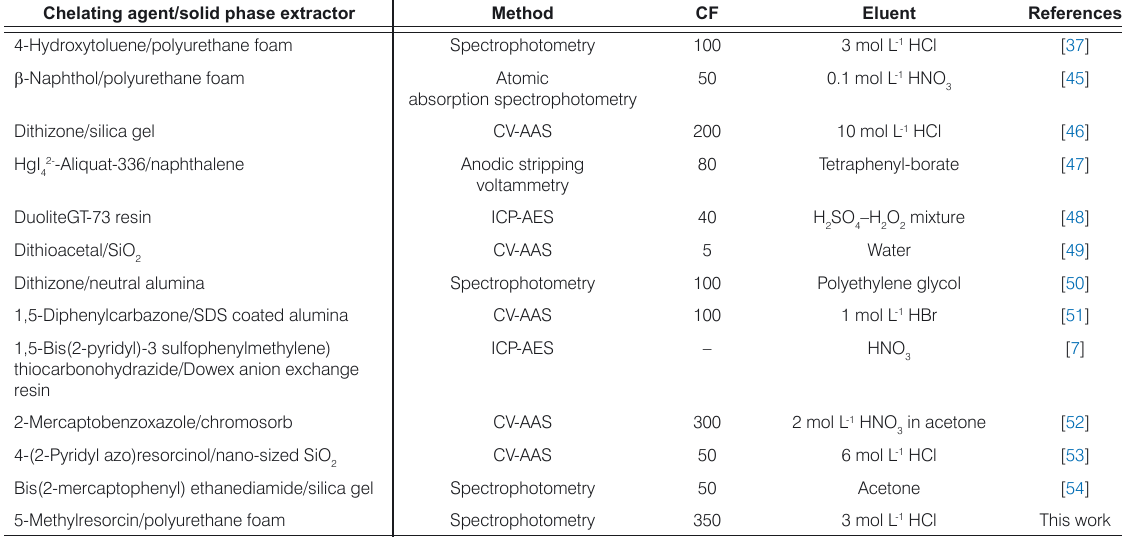
Table 3. Comparison of the preconcentration factors